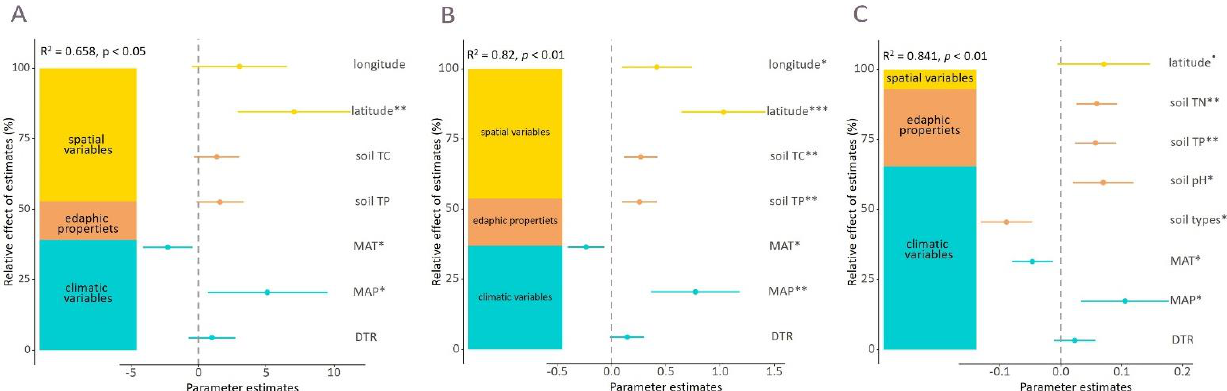
Figure 4. Effect of geospatial and environmental predictors on the phylogenetic diversity (Faith’s PD) ( A , see Figure 3 for interpretation) and the Net Relatedness Index (NRI) and the Nearest Taxon Index (NTI) values are expressed as boxplot ( B ). The p value of each predictor is given as: ** p < 0.01, * p < 0.05, · 0.05 < p < 0.1. Significant differences between mean NRI and NTI values from zero are indicated as: ** p < 0.01, · 0.05 < p < 0.1. We found the two phylogenetic relatedness indices, NRI and NTI, exhibited different patterns. The mean values of the NRI and NTI were −0.483 and 0.355, respectively (Figure 4B), which indicated the phylogenetic dispersion based on the mean pairwise divergence time among co-occurring species, while the phylogenetic clustering was based on the mean of the divergence times between each species and its closest co-occurring relative.